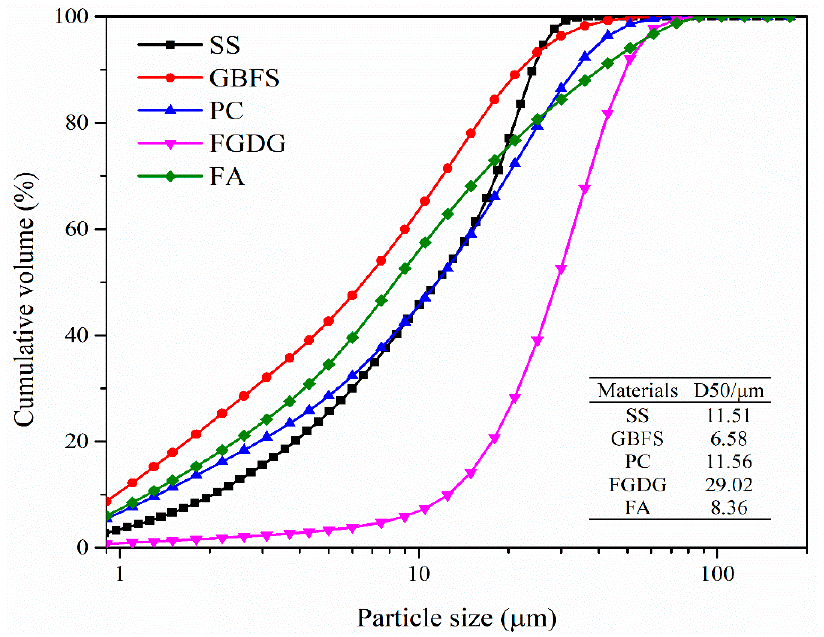
Figure 1. Particle size distributions of raw materials.